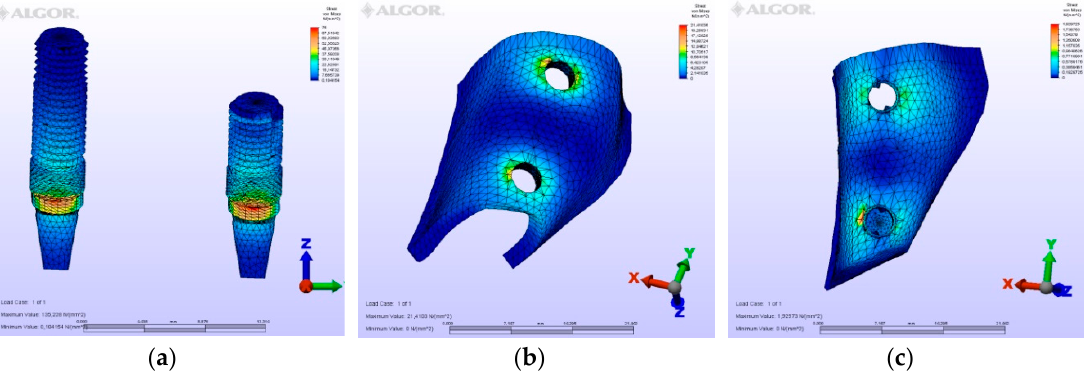
Figure 6. Model M2, oblique loading. ( a ) the maximum von Mises stresses around implants; ( b ) maximum principle stress in cortical bone; ( c ) maximum principle stress in cancellous bone.